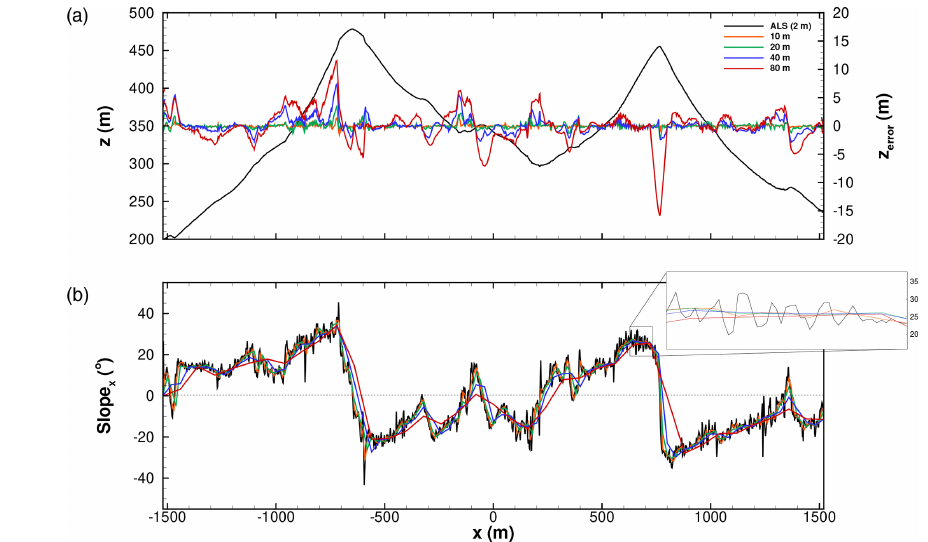
Figure 10. Terrain along transect C (see Fig. 3), ALS-based meshes: (a) terrain profile and elevation error, (b) slope in the x direction.